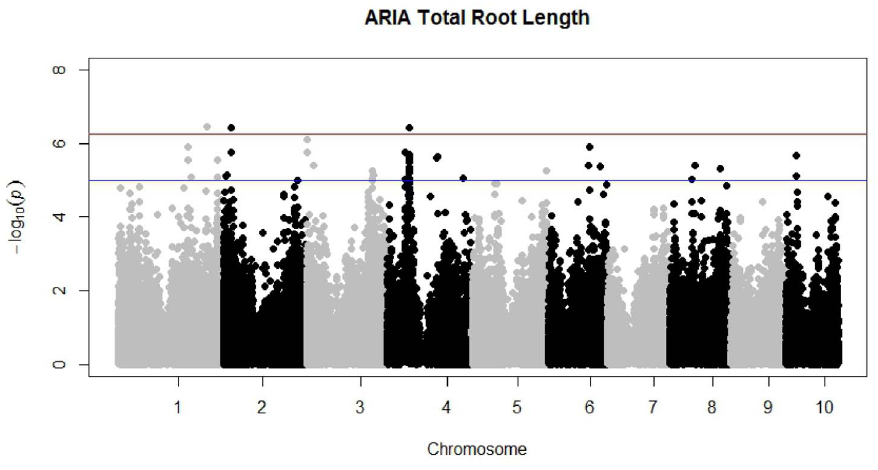
Figure 3. Manhattan plot displaying all 10 maize chromosomes, showing SNP markers significantly associated with trait Total Root Length measured with ARIA . Significant SNPs are located on chromosomes 1, 2, and 4.